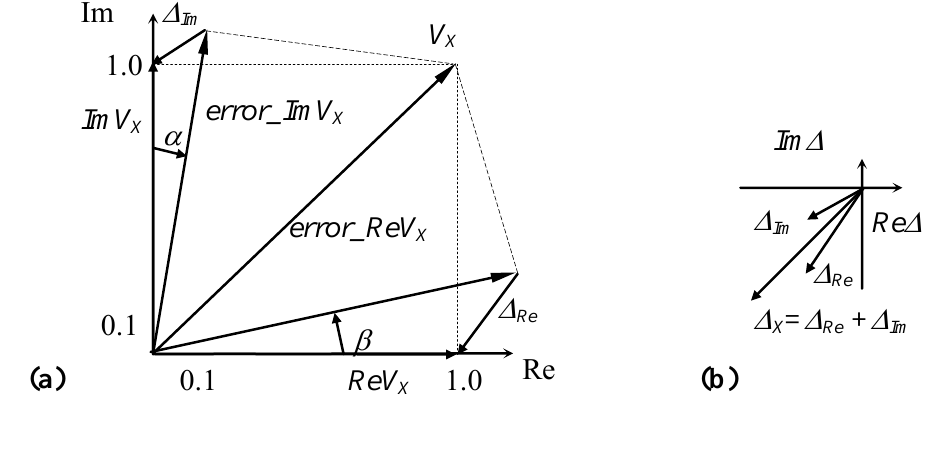
Figure 1. (a) Orthogonal components of the measured complex voltage V due to parasitic rotations of orthogonal